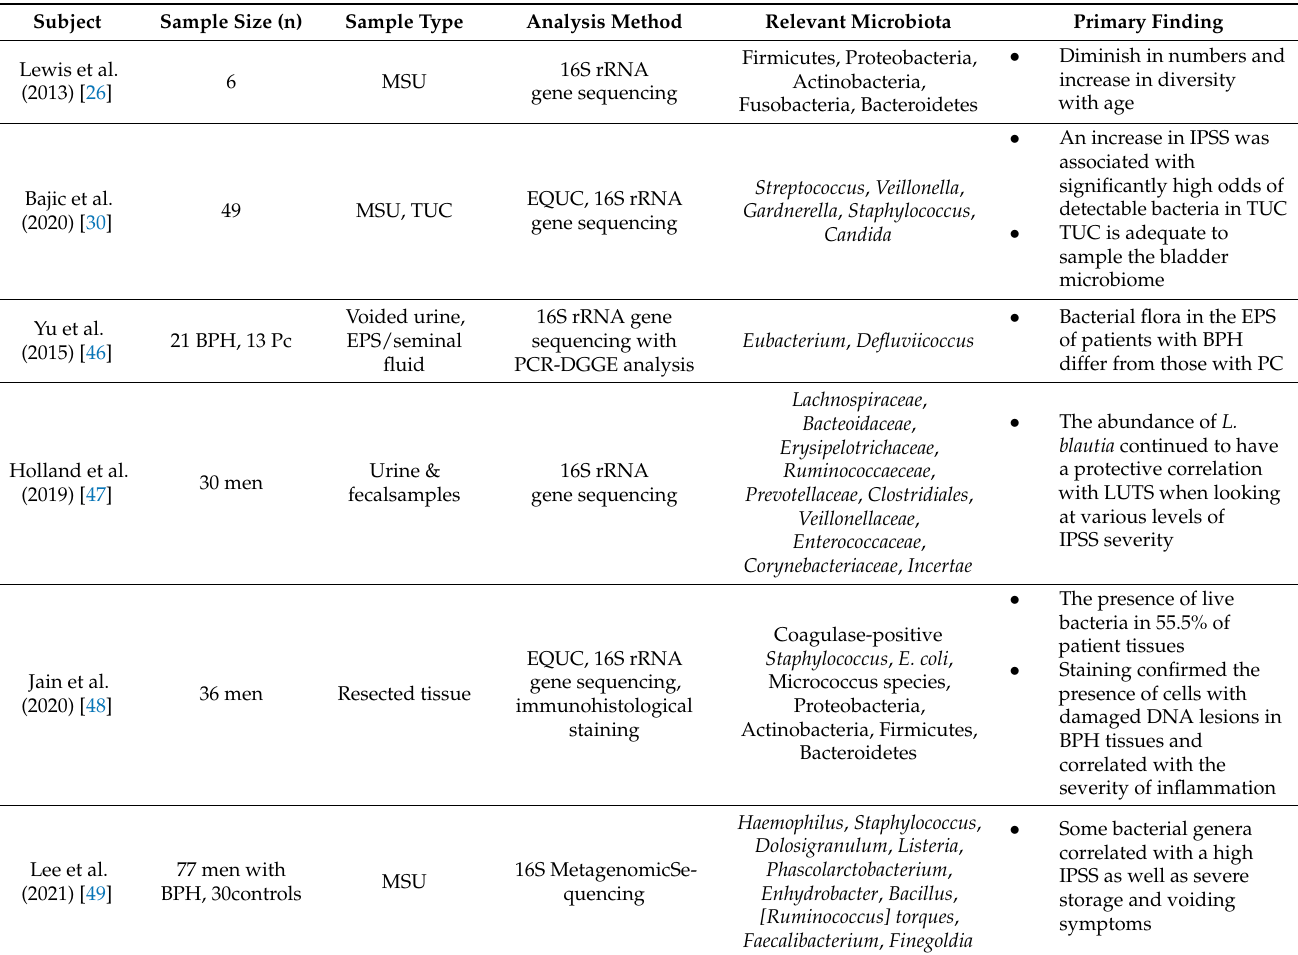
Table 2. Studies investigating the microbiota of males with benign prostatic hyperplasia/lower urinary tract symptoms